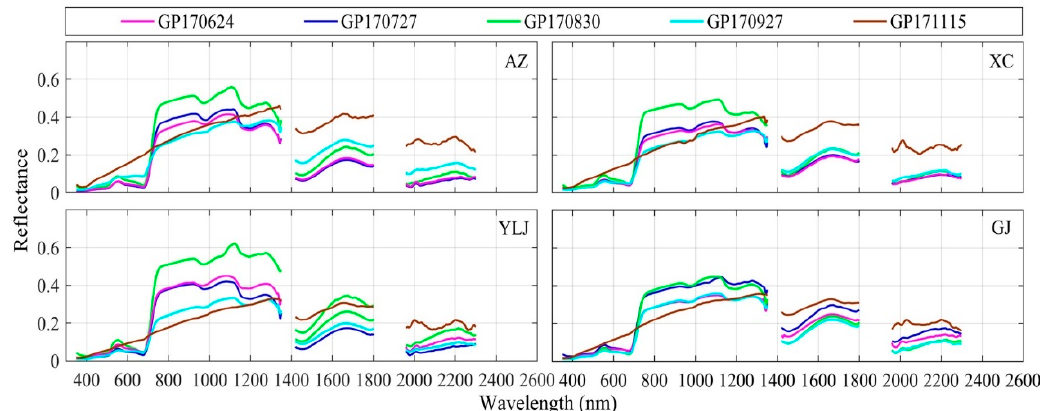
Figure 2. Mean canopy reflectance spectra of forage during different growth periods (the bands distributing in 1351–1420 nm, 1801–1930 nm, and 2301–2500 nm are removed because of the effects of the absorption of leaf water and water vapor).